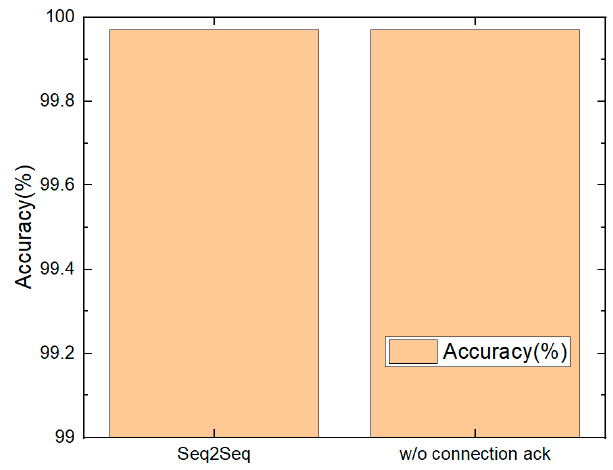
Figure 18. Accuracy when a connection ACK is not used.